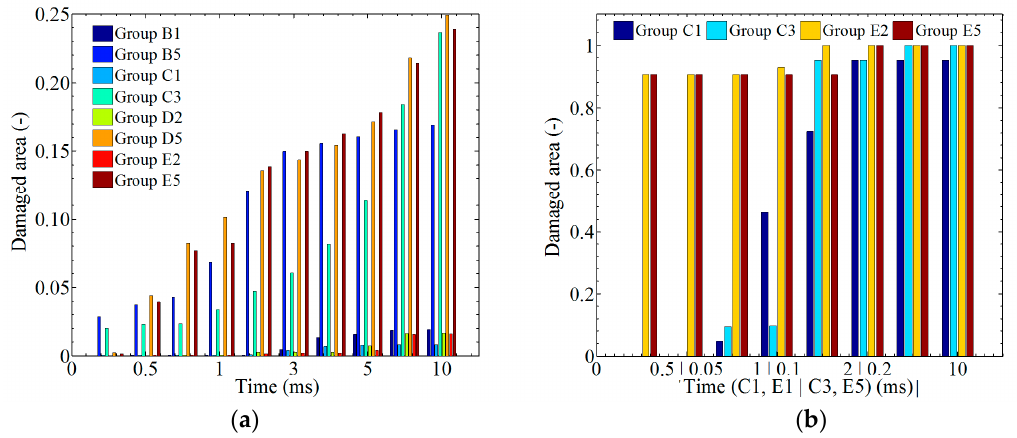
Figure 19. The statistics of the general damage area: ( a ) laminate; ( b )